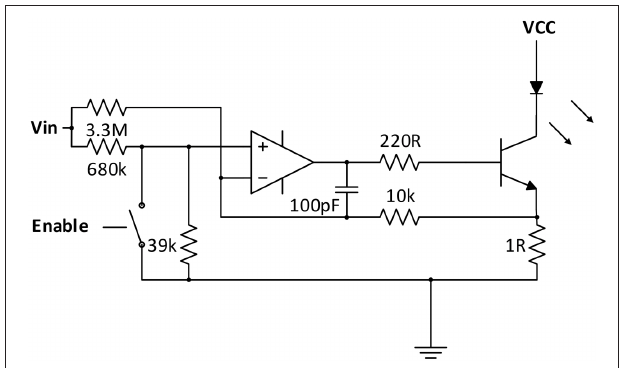
FIGURE 2 | Current regulator/modulator circuit.